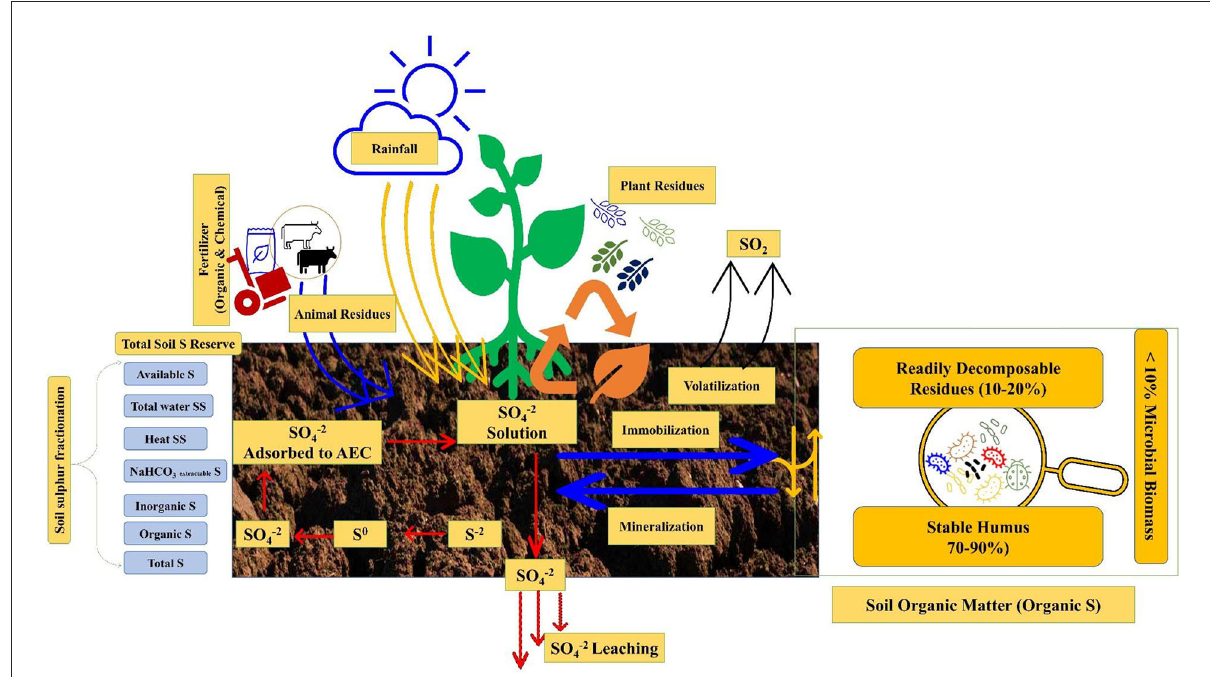
FIGURE1 Sulfur availability in soils: (i) soil organic matter quantity and quality, (ii) crop selection and cropping system design, (iii) and (iv) biological and biochemical mineralization rates. In addition to soil test S concentrations, these factors should be considered when making fertility